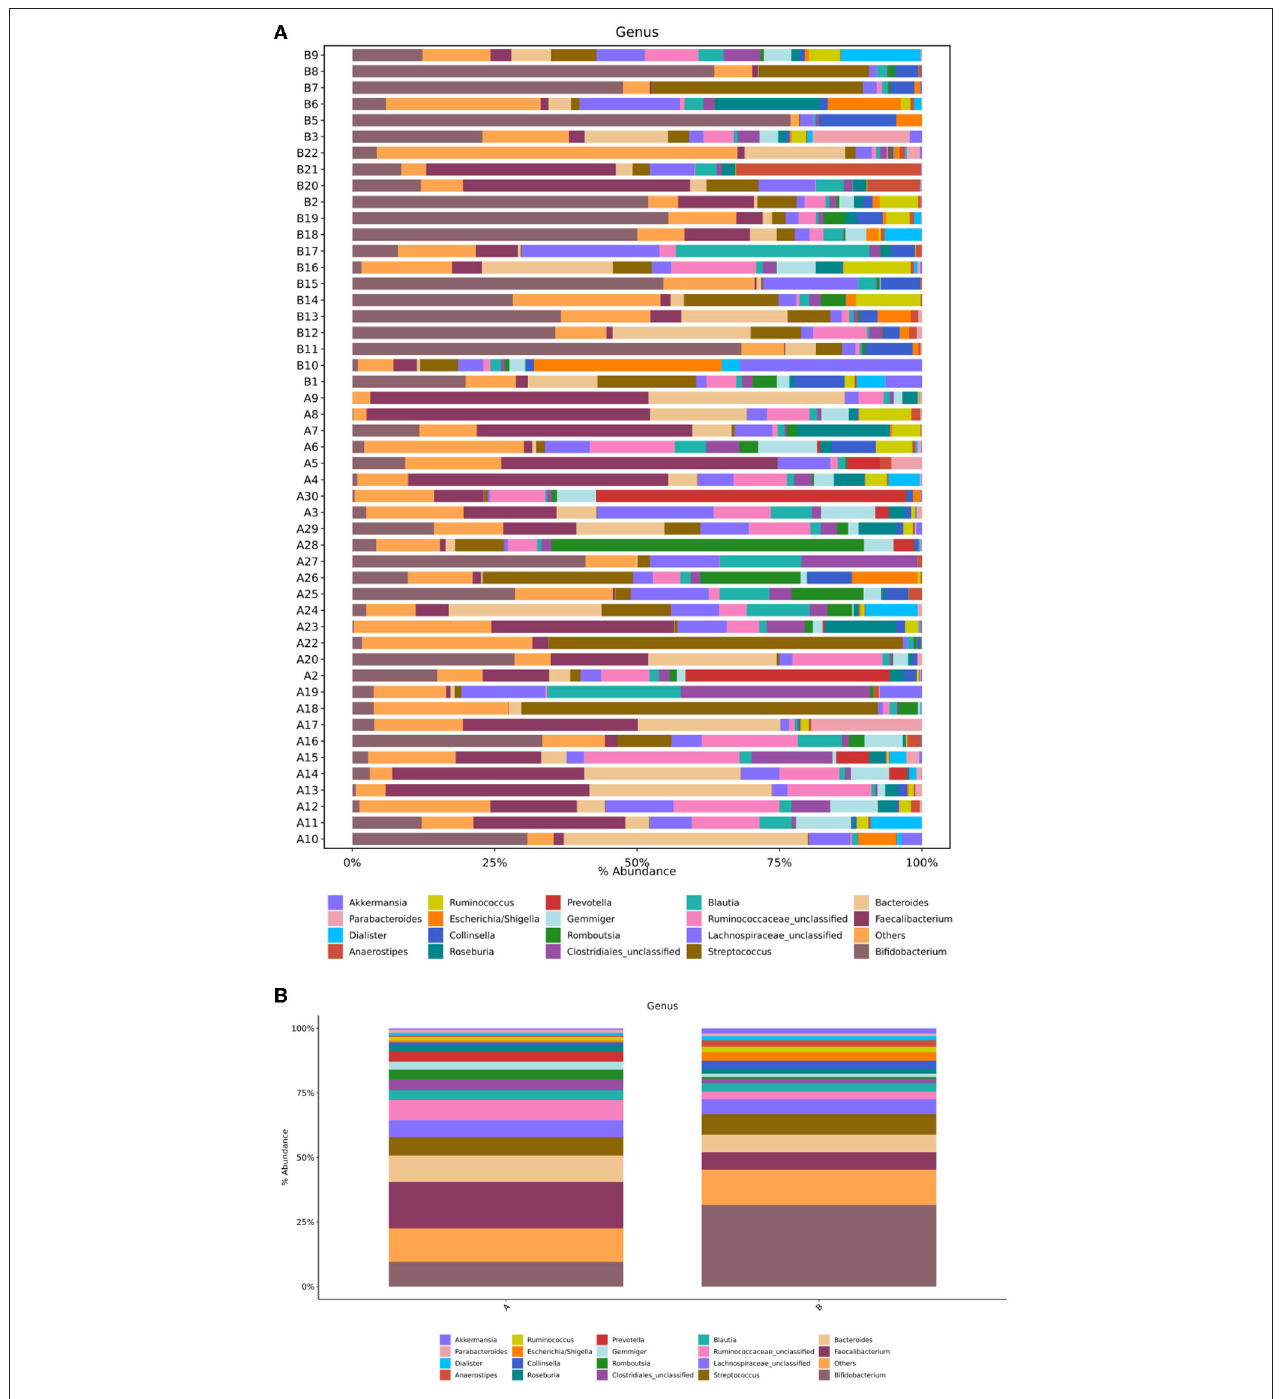
FIGURE 4 | (A) Structural composition analysis of the gut microbiota in each sample at the genus level. (B) Comparison of relative abundance and composition of bacteria in the two groups at the genus level. Group A, TD group; Group B, control group.